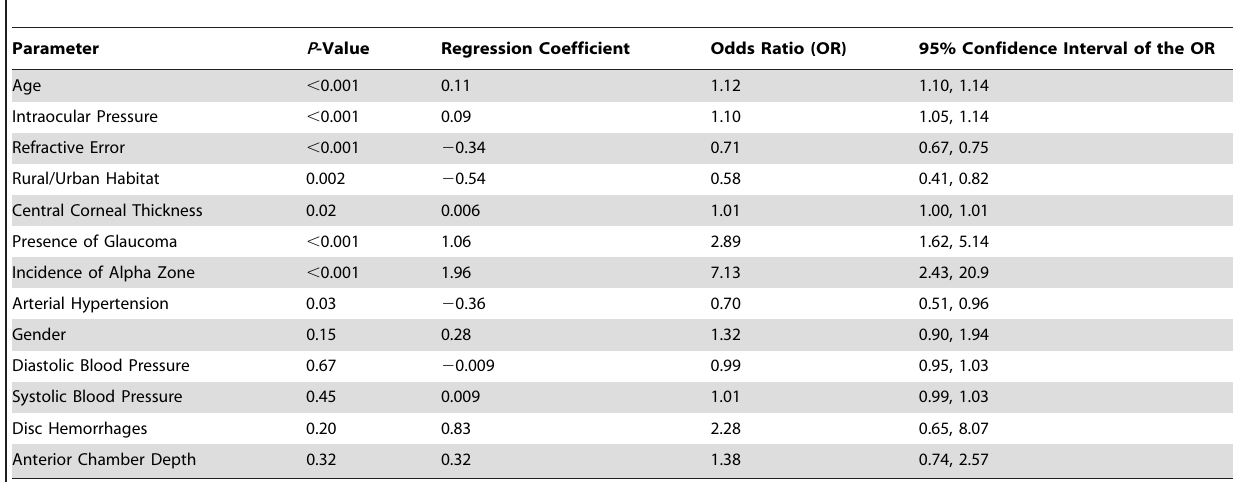
Table 2. Logistic binary regression analysis for the associations with the incidence of beta zone of parapapillary atrophy during a 5-year follow-up of the Beijing Eye